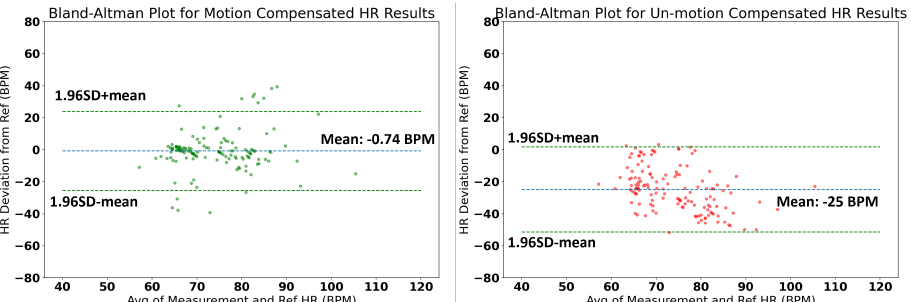
Figure 14. Bland–Altman plot of HR measurements when participants drive on the highway with motion compensation ( left ) and without motion compensation ( right ).